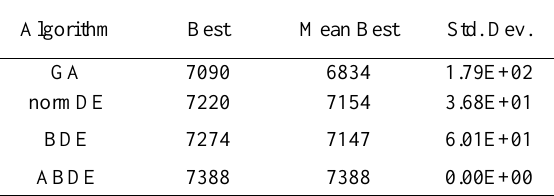
Table 2 Solutions to 0-1 knapsack problem